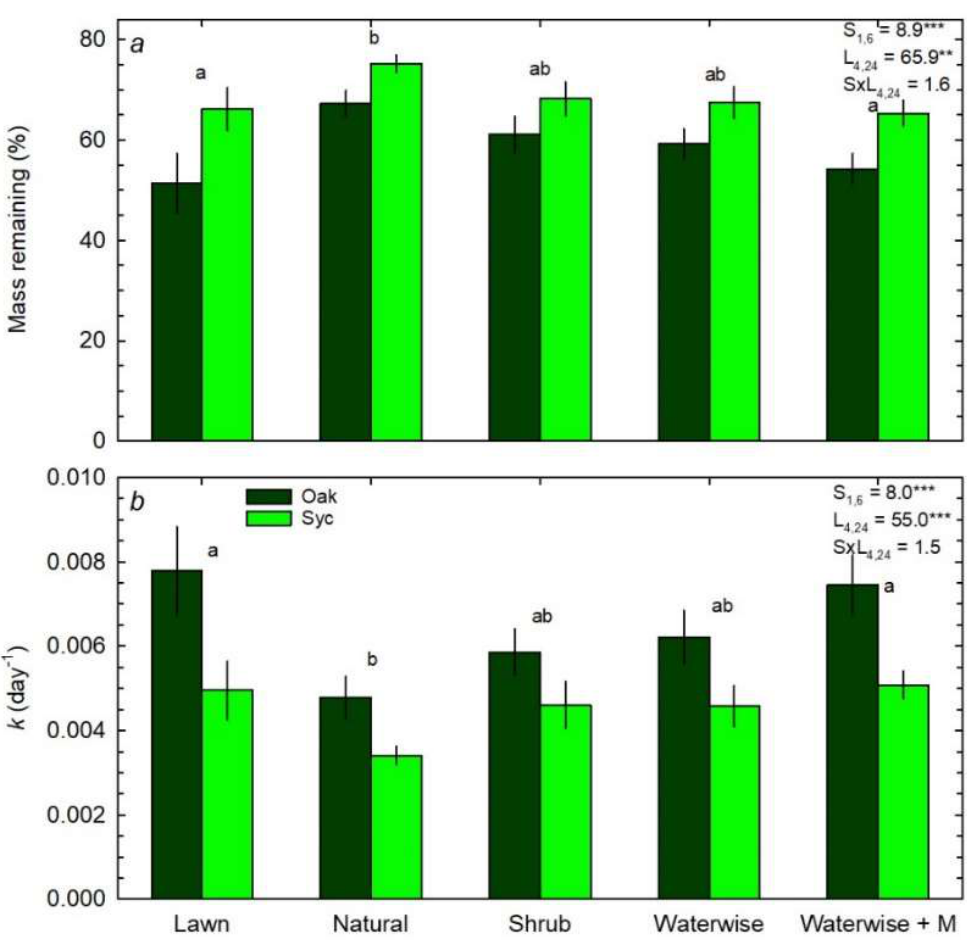
Figure 3. Mean ( ± se; n = 7) percentage of initial mass remaining ( a ) and the mass loss rate Figure 3. Mean (±se; n = 7) percentage of initial mass remaining ( a ) and the mass loss rate constant ( k ) ( b ) constant ( k ) ( b ) from decomposing oak (dark-green bars) and sycamore (light-green bars) leaves. from decomposing oak (dark-green bars) and sycamore (light-green bars) leaves. Shown also are the re- Shown also are the results of a 2-way ANOVA (F-statistic, degrees of freedom, and p -value) with sults of a 2-way ANOVA (F-statistic, degrees of freedom, and p -value) with leaf substrate (S) and land- leaf substrate (S) and landcover type (L) as fixed effects and the substrate x landcover (S × L) inter- cover type (L) as fixed effects and the substrate x landcover (S × L) interaction. In the event of a significant action. In the event of a significant ANOVA for site, a Tukey–Kramer post hoc test was run to see ANOVA for site, a Tukey–Kramer post hoc test was run to see which landcovers were significantly which landcovers were significantly different. Means with different letters are significantly different. different. Means with different letters are significantly different. ** p < 0.01; *** p < 0.001. ** p < 0.01; *** p <